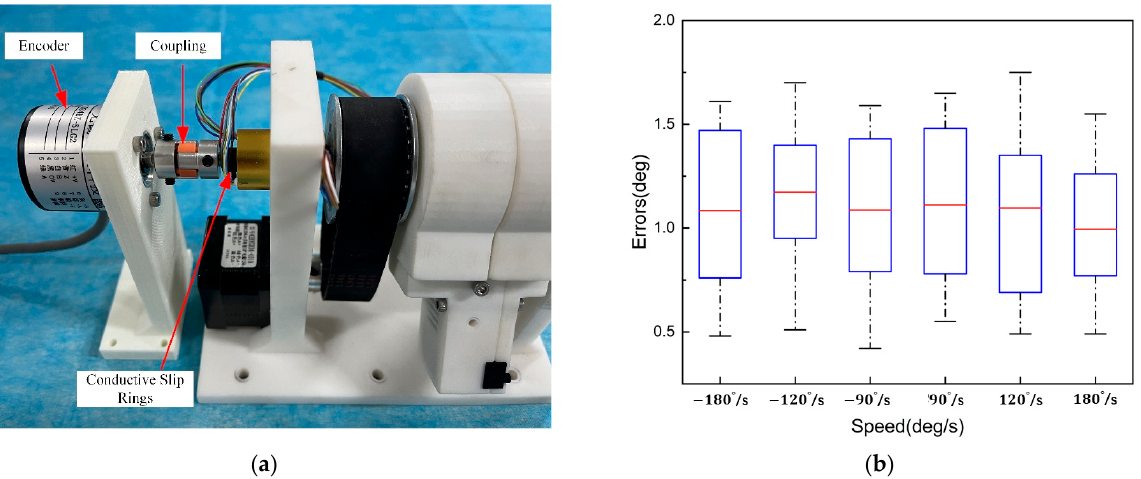
Figure 16. Catheter rotation unit verification experiment. ( a ) Experimental platform construction. ( b ) Experimental error.